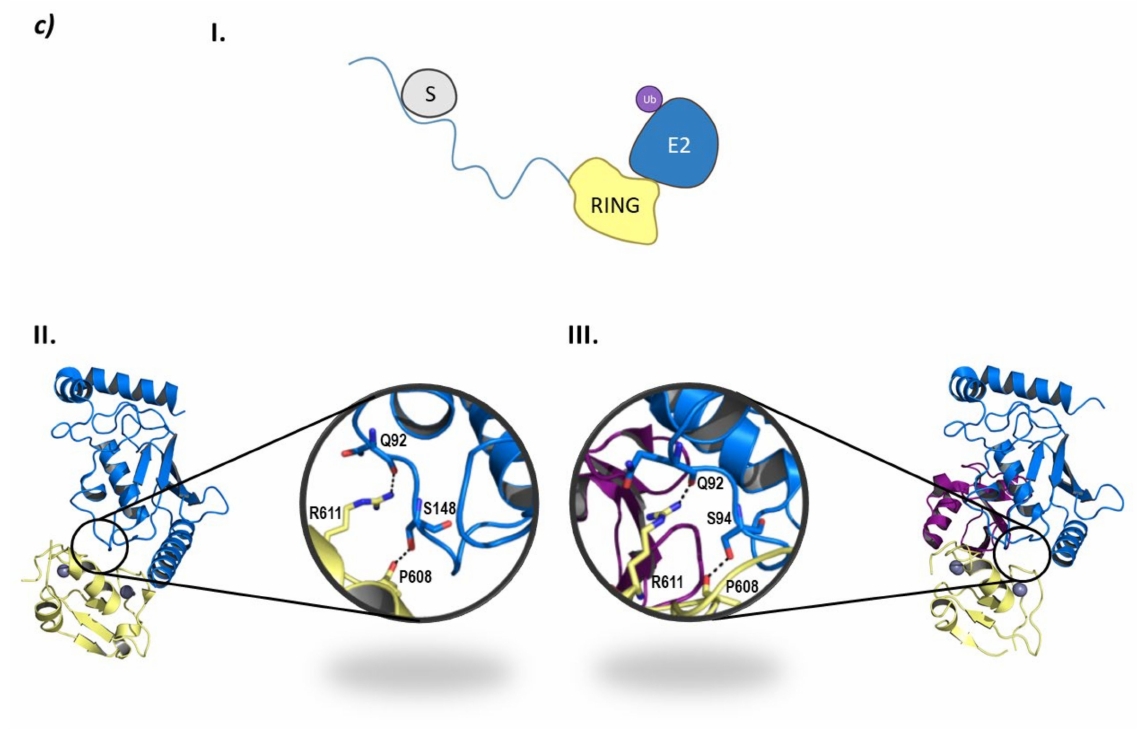
Figure 8. Monomeric RING E3 ligases. ( a ) CHFR E3 ligase. I is the schematic representation of the assembly of the CHFR E3 ligase: ubiquitin (Ub) in purple, E2 ligase (E2) in dark blue, Ring domain (RING) in yellow, substrate recognition domain FHA (FHA) in light blue, substrate protein in grey, and the cysteine rich domain (CRD) in orange. Protein assembly II is the 3D representation of the monomeric and dimeric conformations of FHA as found in PDB code 1LGQ. Protein assembly III is the 3D representation of the CRD domain as found in PDB code 2XP0. ( b ) PIRH2 E3 ligase. I is the Schematic representation of the assembly of the PIRH2 E3 ligase: ubiquitin (Ub) in purple, E2 ligase (E2) in dark blue, Ring domain (RING) in yellow, the N -terminal domain (NTD) in turquoise, the C -termina domain (CTD) in light blue, and the substrate protein in grey. Protein assembly II is the 3D representation of the NTD as found in PDB code 2K2C. Protein assembly III is the 3D representation of the RING domain as found in PDB code 2JRJ. Protein assembly IV is the 3D representation of the CTD as found in PDB code 2K2D. ( c ) RLIM E3 ligase. I is the Schematic representation of the assembly of the RLIM E3 ligase: ubiquitin (Ub) in purple, E2 ligase (E2) in dark blue, Ring domain (RING) in yellow, the disordered N -terminal end in light blue, and the substrate protein in grey. Protein assembly II is the 3D representation of the RING domain bound to the E2 ligase Ube2e2 as found in PDB code 6W9A. Protein assembly III is the 3D representation of the RING domain bound to the E2 ligase Ube2d2 as found in PDB code 6W9D. Hydrogen bonds are shown as dashed lines and zinc ions as grey